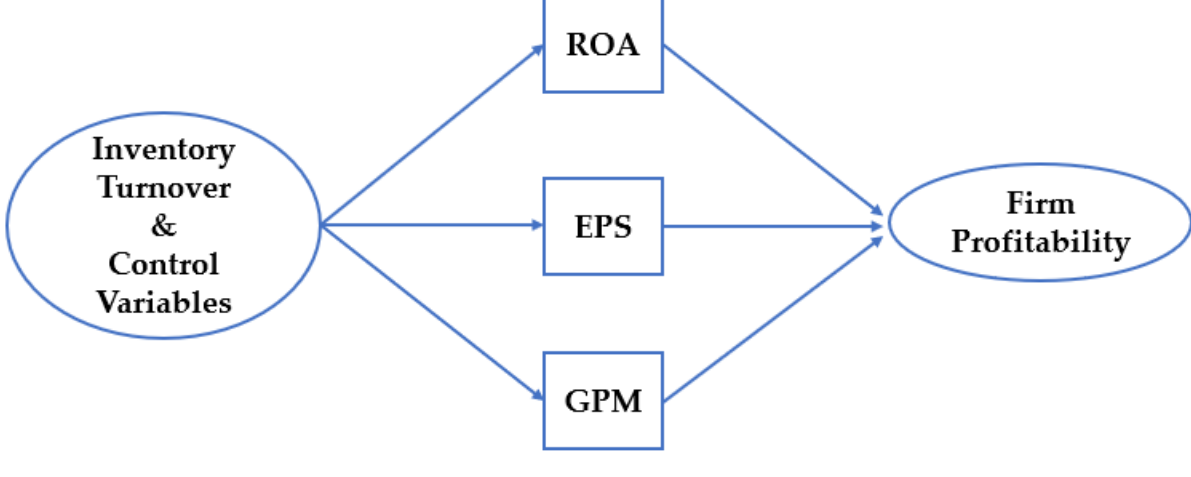
Figure 1. Research model.